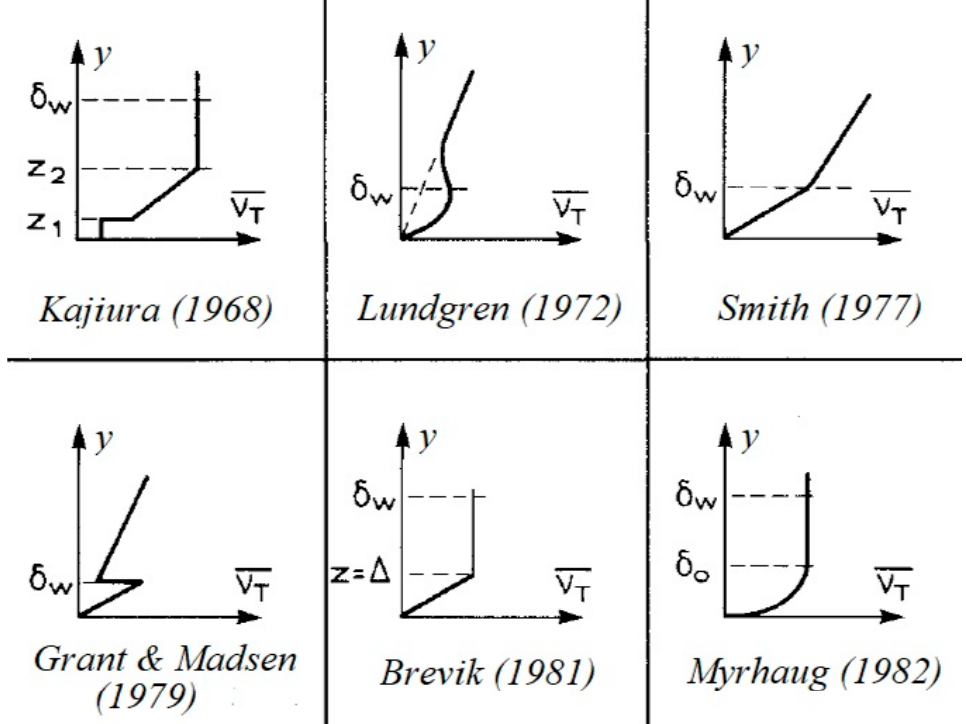
Figure 1. Assumptions for the vertical variation of eddy viscosity in the bottom boundary layer, (adapted with permission from